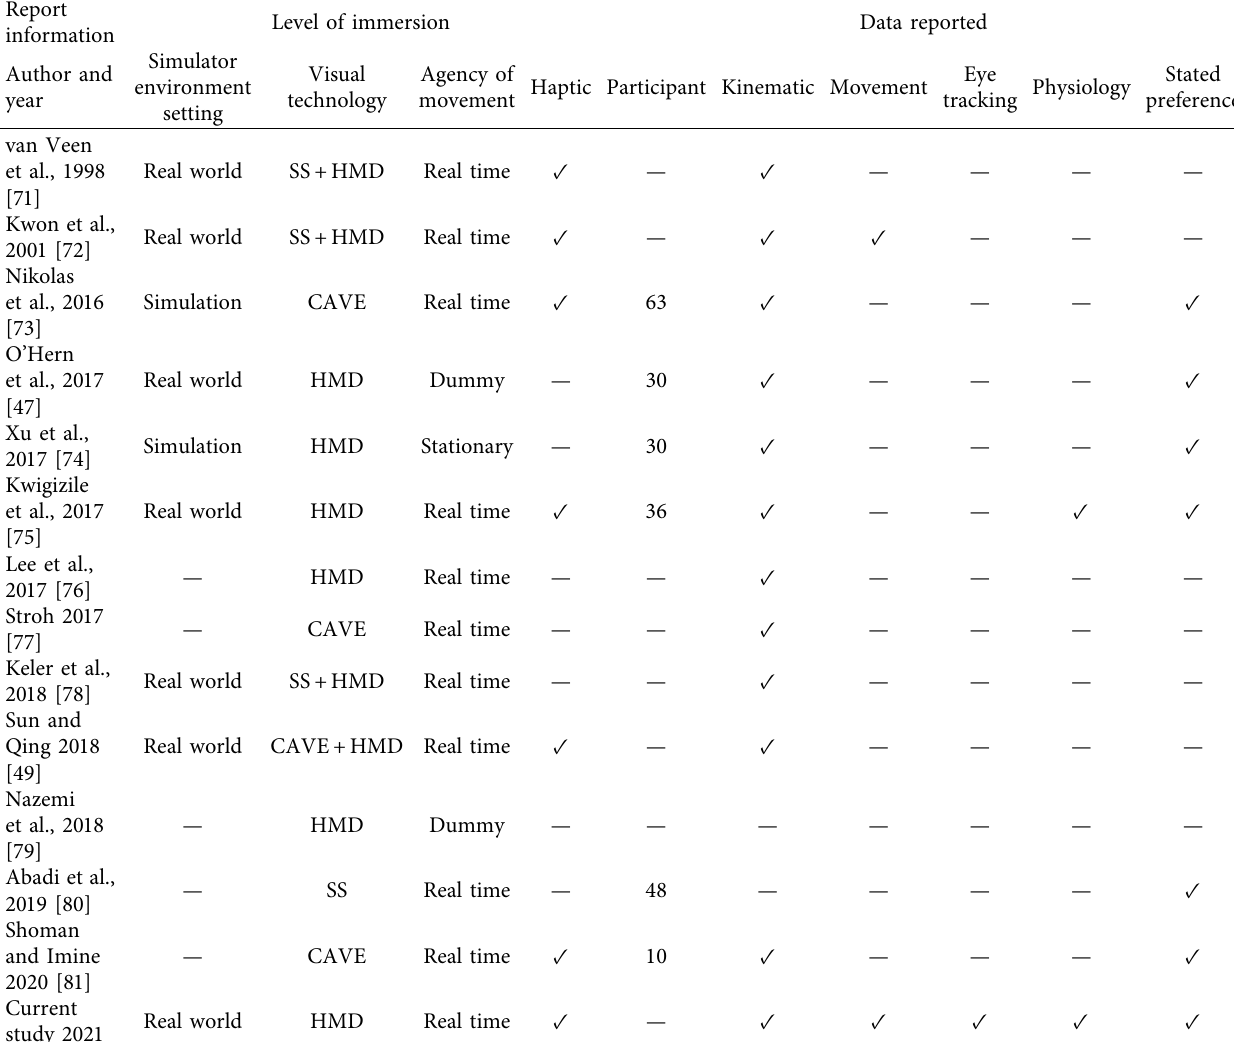
Table 2: IVE bicyclist simulator literature